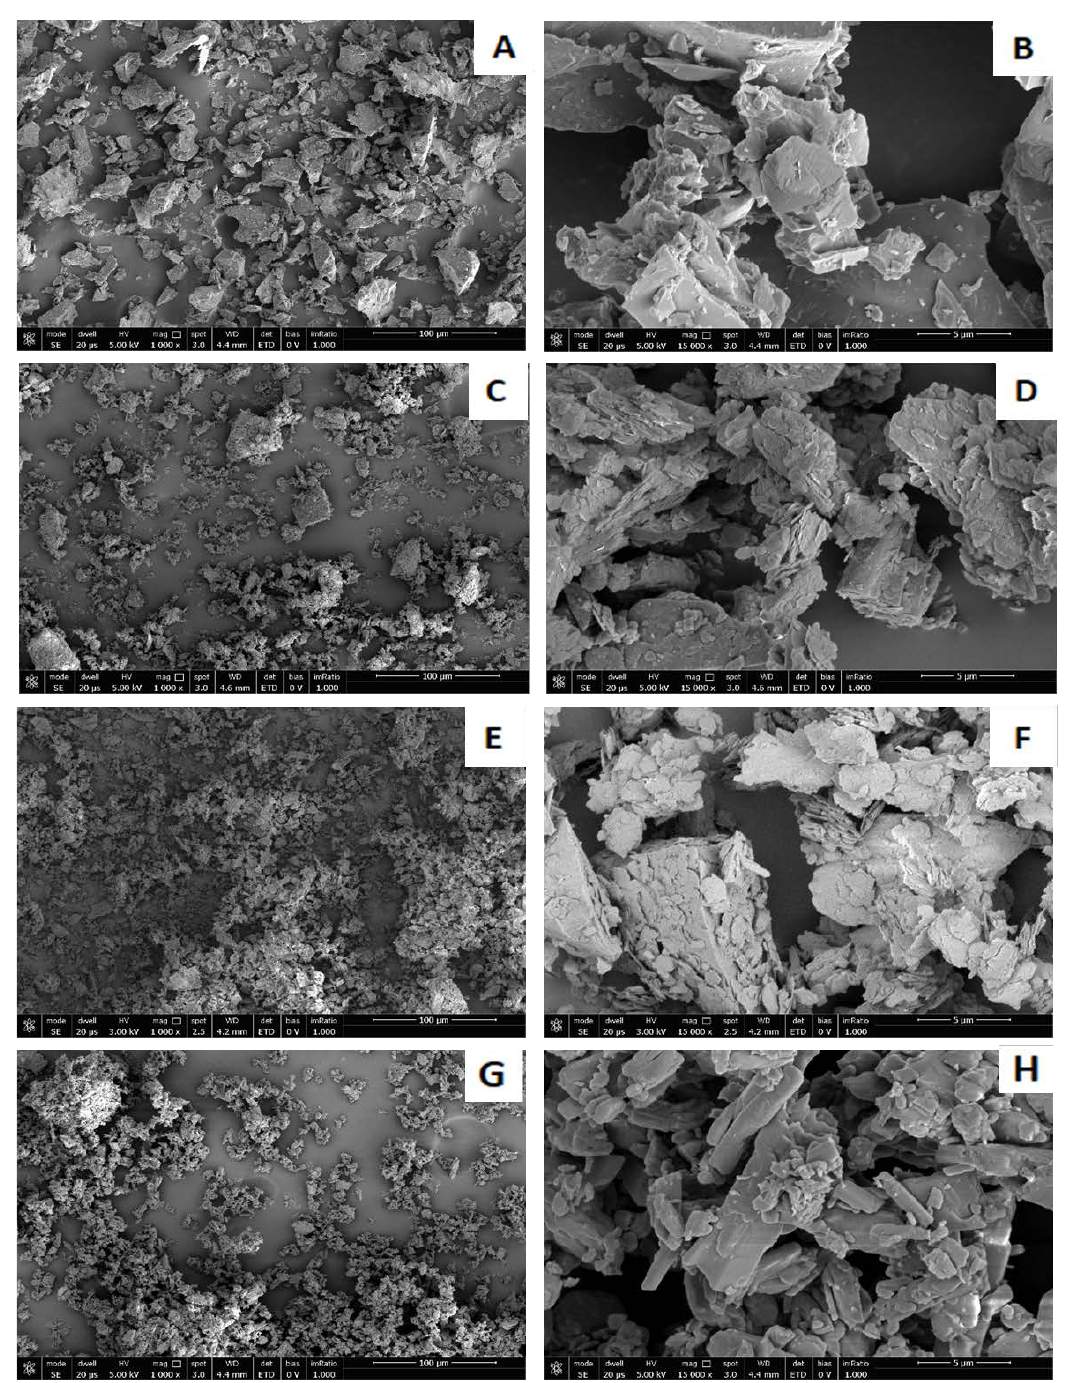
Figure 3. Scanning Electron Microscope (SEM) images of PS ( A , B ), RP ( C , D ), RP dry ( E , F ), and Gy ( G , H ) waste at 1000× and 15,000× magnifications.